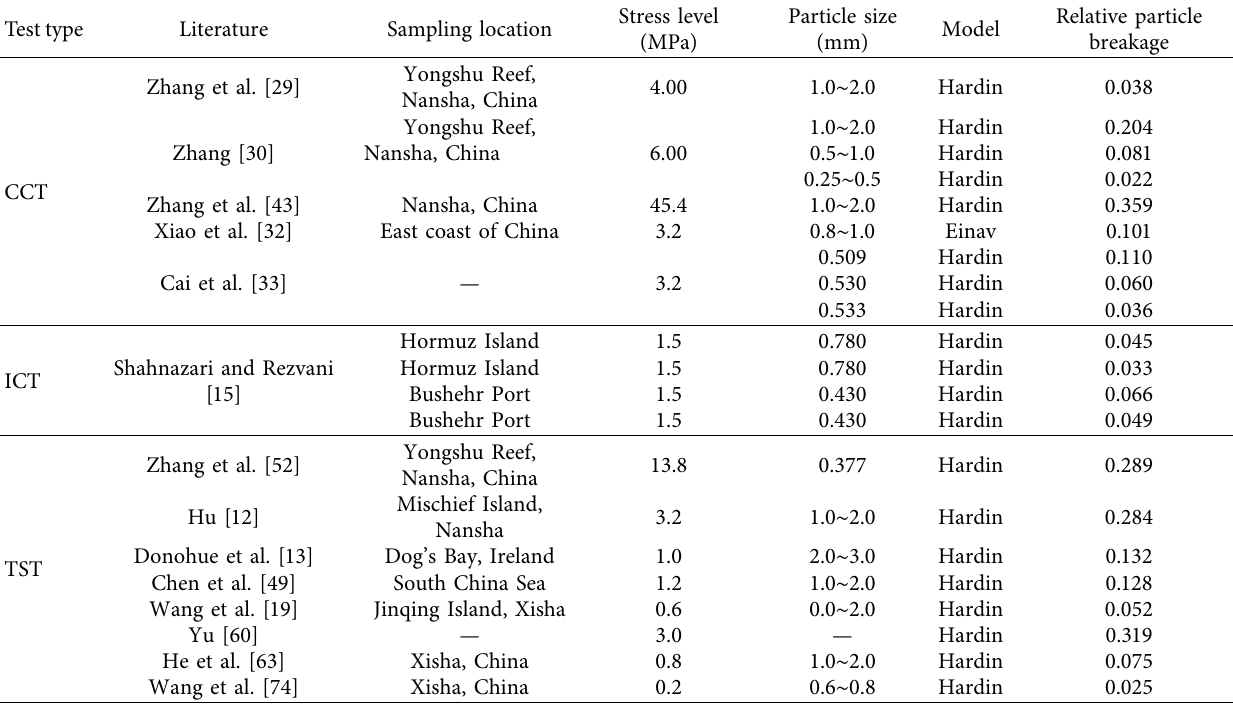
Table 2: Summary of the particle breakage ratio of calcareous